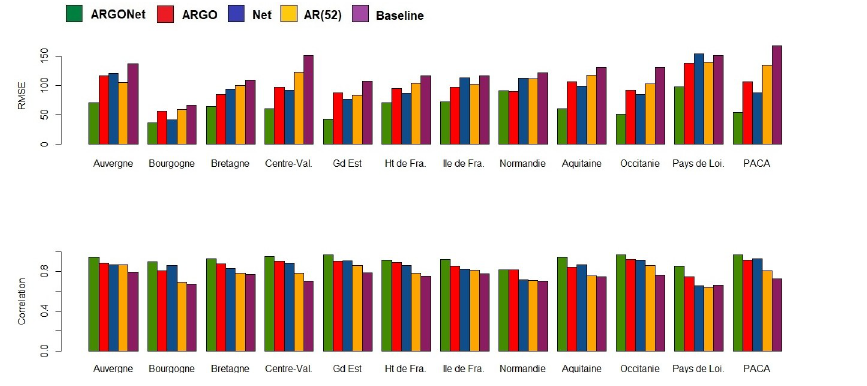
Fig 6. Correlation distribution.